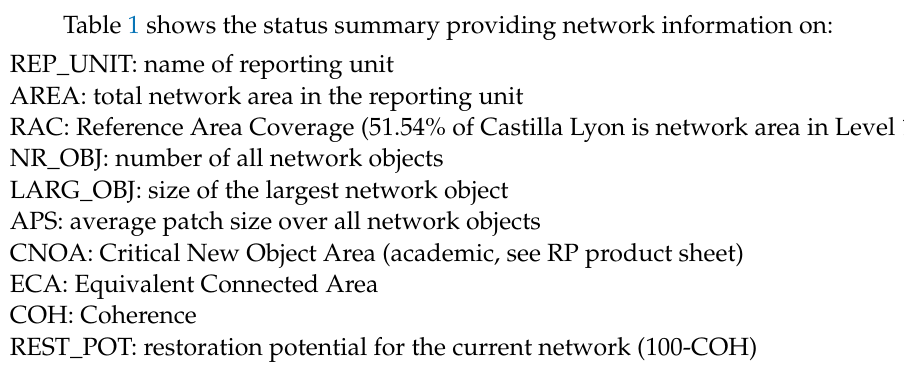
Table 1. Network status summary for the three